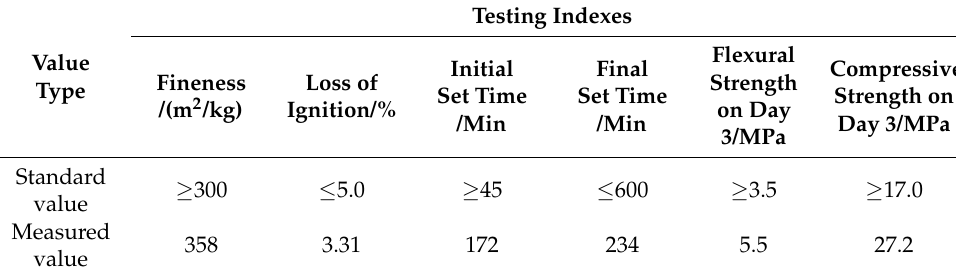
Table 2. Physical and mechanical properties of cement.